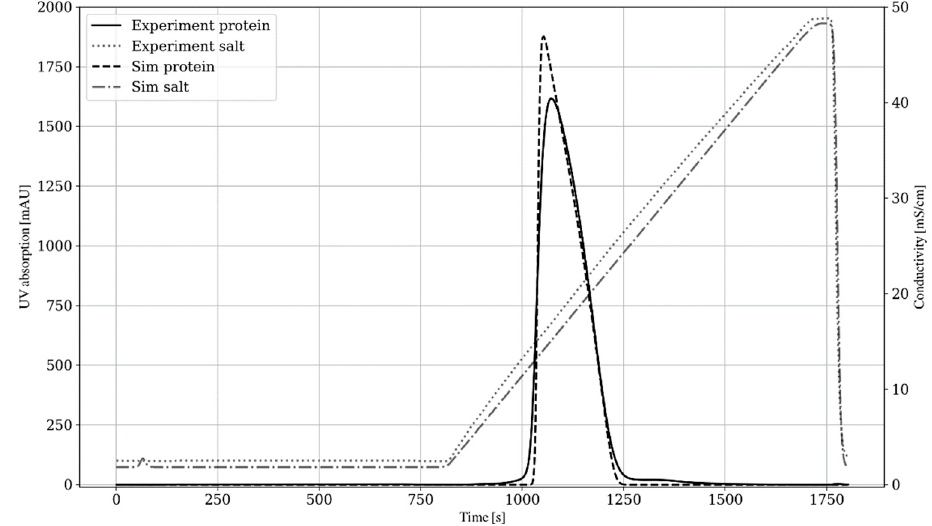
Figure 4. Overloaded experiment with a calibrated